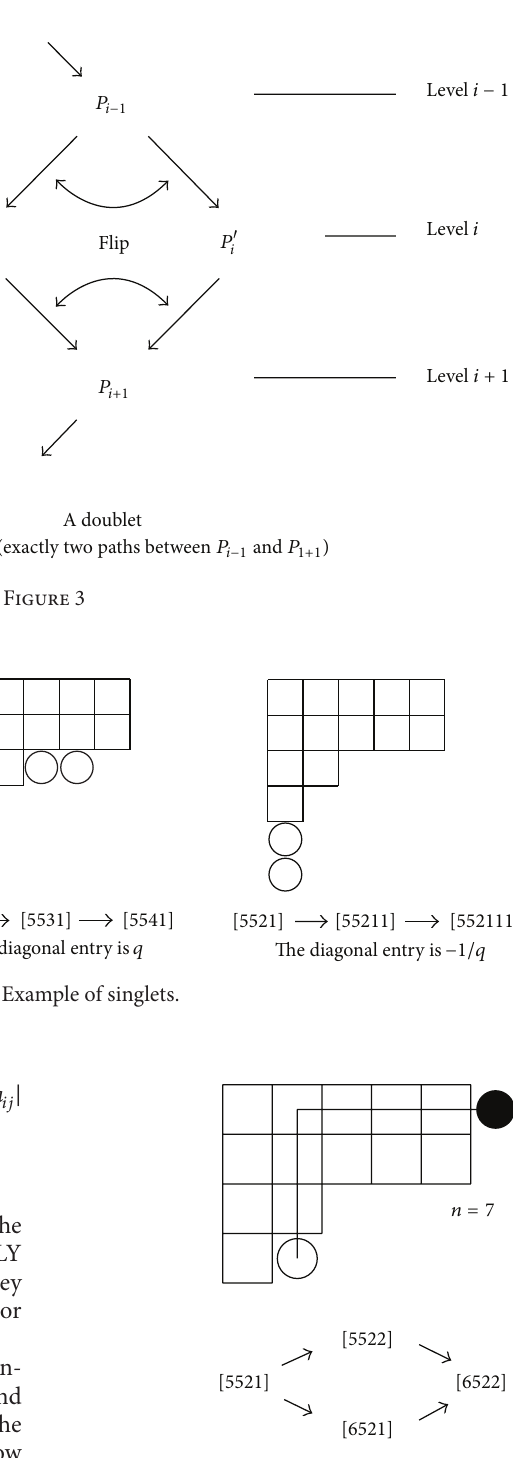
Figure 5: Example of